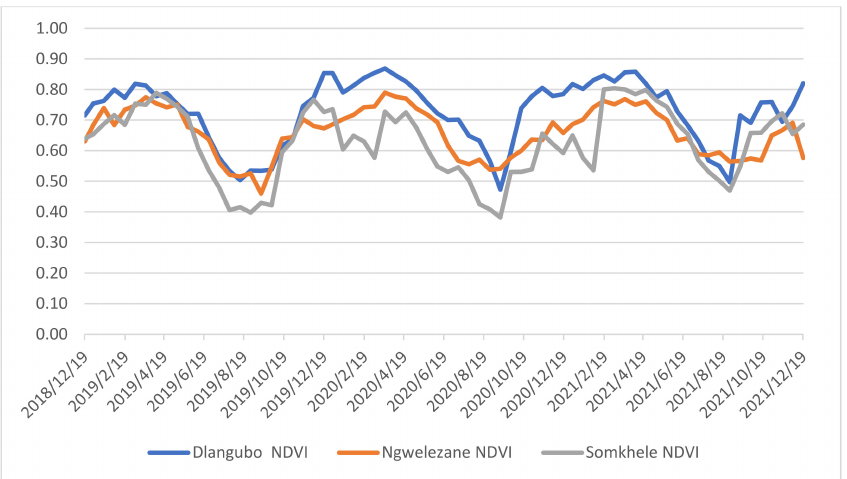
Figure 2. Time series of the Normalized Difference Vegetation Index of the Dlangubo, Ngwelezane, and Somkhele (Mtubatuba) sites from 19 December 2018 to 19 December 2021. Higher NDVI values (>0.5) were an indication of the presence of healthy green vegetation. As the value decreased, the healthiness of the vegetation declined. Values below 0.5 show very poor vegetation [35], and it only occurred at the Somkhele site and only in season